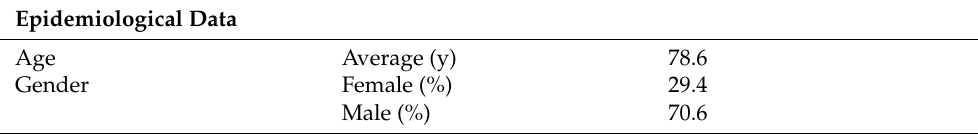
Table 1. Demographic data of the cSCC patients included in the study (17 patients with 22 tumors), y =